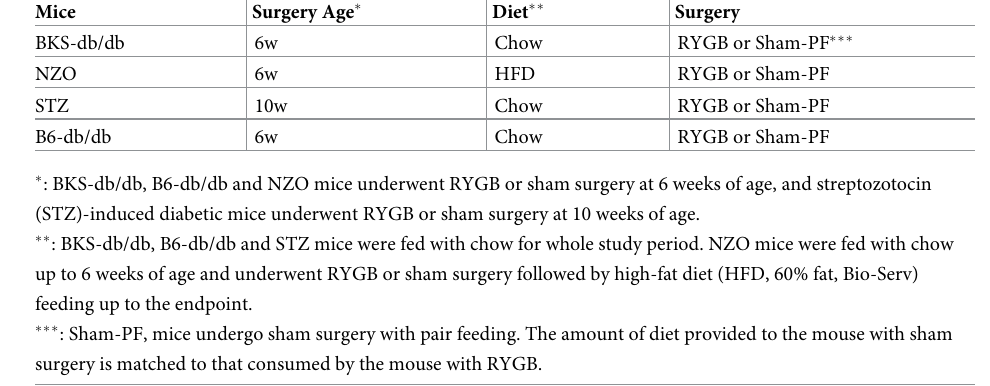
Table 1. Mouse models and diet. Mice Surgery Age � Diet �� Surgery BKS-db/db 6w Chow RYGB or Sham-PF ��� NZO 6w HFD RYGB or Sham-PF STZ 10w Chow RYGB or Sham-PF B6-db/db 6w Chow RYGB or